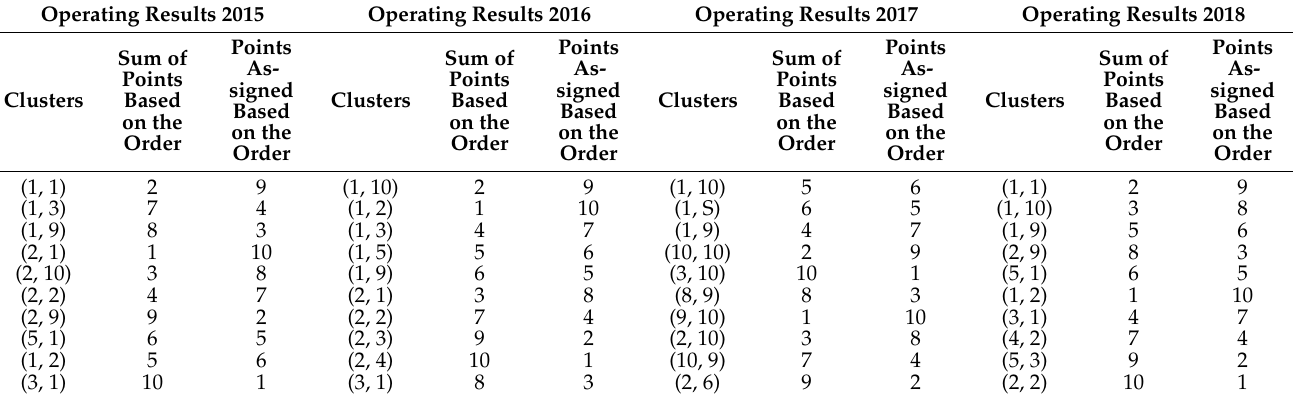
Table 28. Evaluation of clusters based on their order—years 2015–2018 (Operating result).